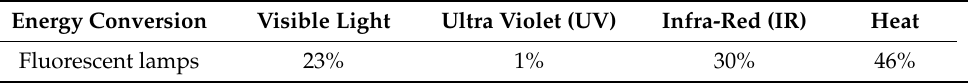
Table 1. Average distribution of the transformation of electrical energy in fluorescent tubes. Energy Conversion Visible Light Ultra Violet (UV) Infra-Red (IR) Fluorescent lamps